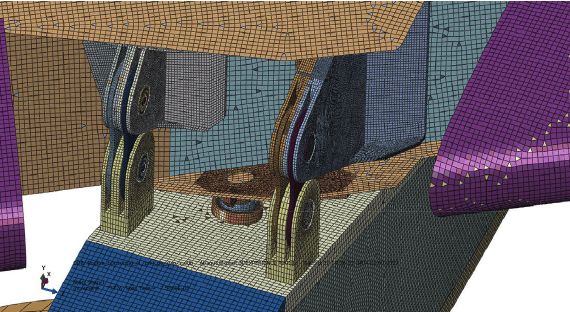
Figure 3: FE model of separation structure.